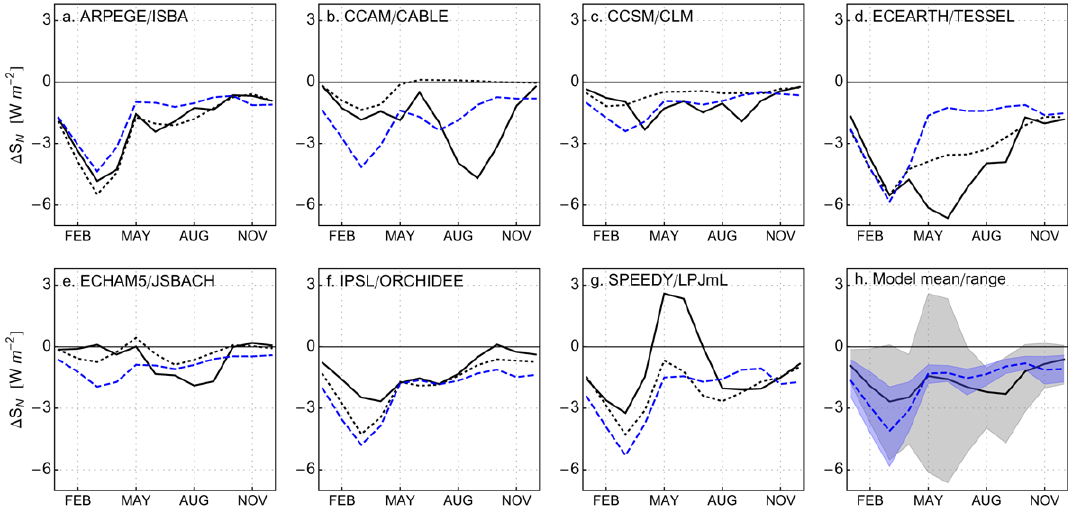
Fig. 10. As in Fig. 7 but for net shortwave radiation ( S N ) . Simulated total and albedo-driven (see text) changes in S N as solid and dotted lines, respectively. Dashed lines indicate the albedo-driven S N changes obtained with the reconstructed (MODIS-based) changes in surface albedo. Table 4. As is Table 3 but for surface net shortwave radiation (Wm − 2 ) . GCM/LSMs ARPEGE/ CCAM/ CCSM/ ECEARTH/ ECHAMS/ IPSL/ SPEEDY/ Model mean ISBA CABLE CLM TESSEL